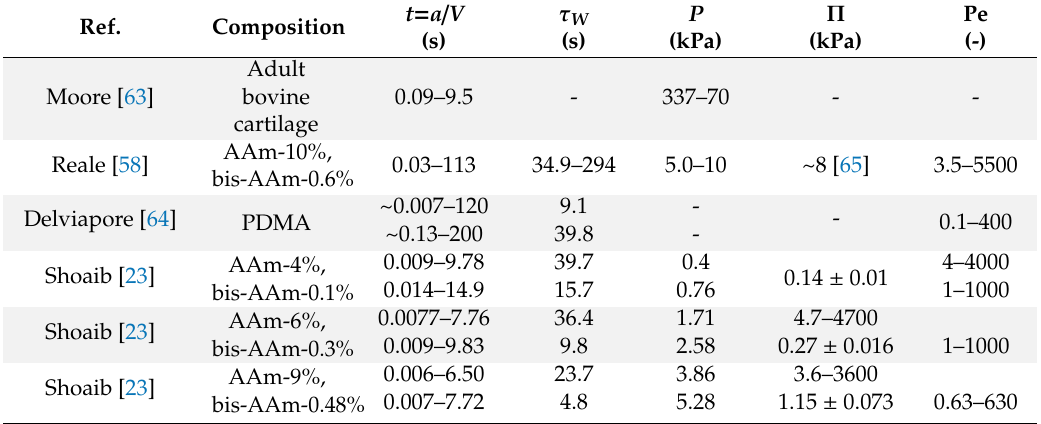
Table 4. Comparisons of contact times ( t ), poroelastic times ( τ W ), Peclet numbers (Pe) and applied pressure ( P ). The osmotic pressure, Π , of a polymer swollen in equilibrium with a good solvent is close to the shear storage modulus, G [14], and was measured only in some works. The data include polyacrylamide hydrogels with di ff erent monomer (acrylamide, AAm) and crosslinker (bisacrylamide, bis-AAm) concentrations from Ref. [23], PDMA hydrogels from Ref. [64] and adult bovine cartilage from Ref.